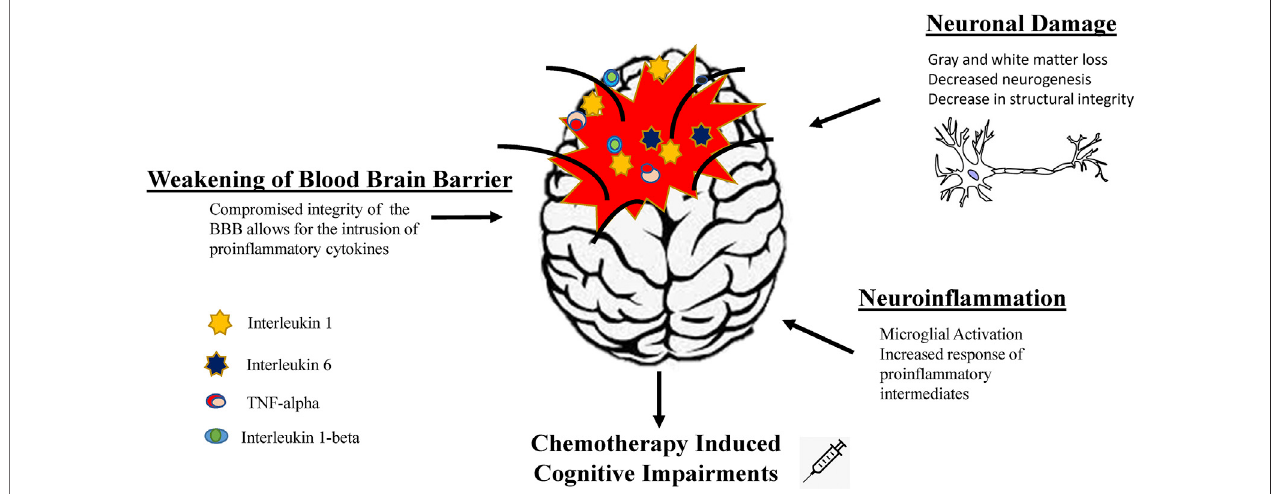
FIGURE7| Simpli fi edschematicformechanismsofchemotherapyinducedcognitiveimpairments.Thisschematicservesasanoverviewoffactorassociatedwith long-term cognitive dysfunctions via chemotherapy usage. These factors include neuroin fl ammation, neuronal dysfunction, and compromise in blood brain barrier integrity, which can directly and indirectly induce cognitive